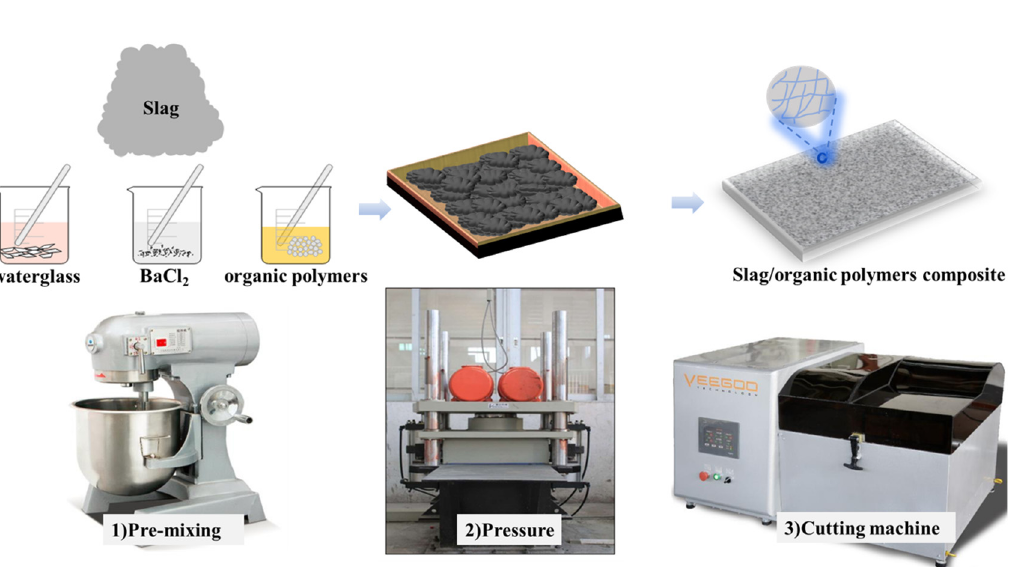
Figure 2. Schematic illustration of fabrication process of organic–inorganic composite geopolymer paste.